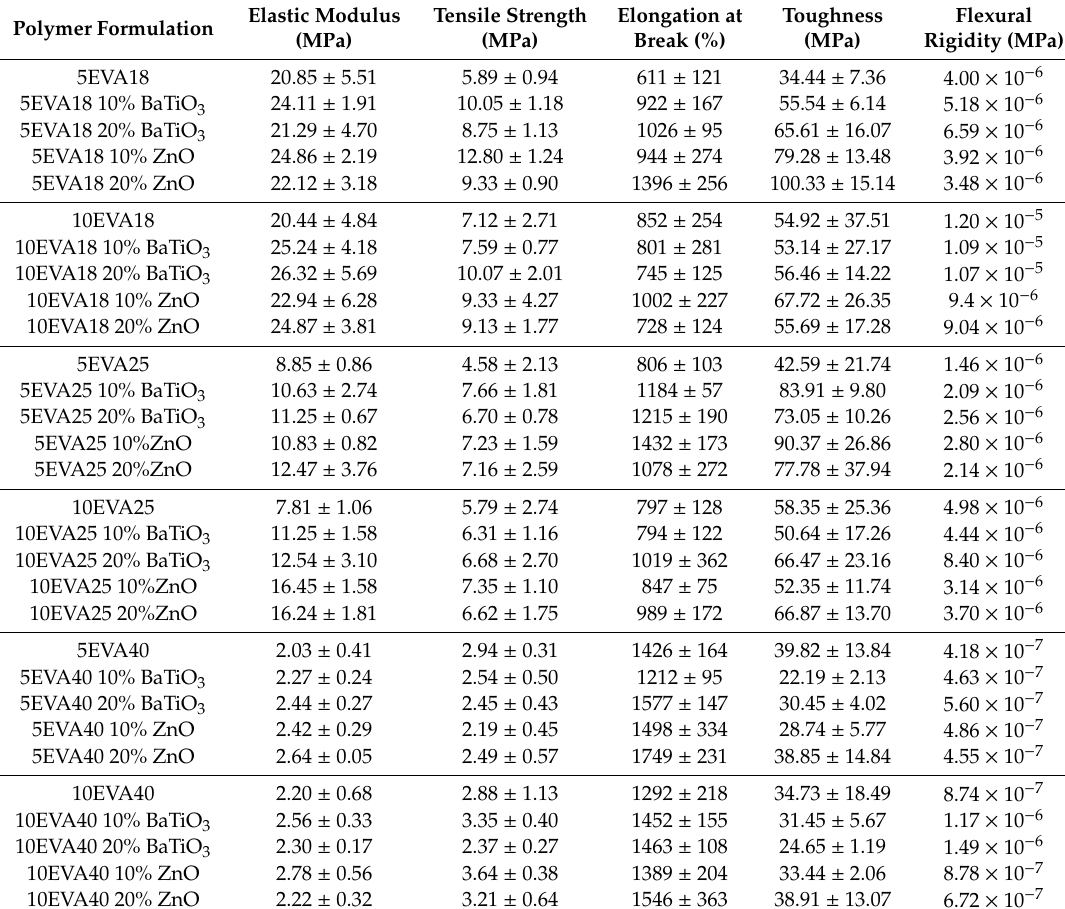
Table 1. Mechanical analysis on the di ff erent material formulations: elastic modulus, tensile strength, elongation at break, toughness, and flexural